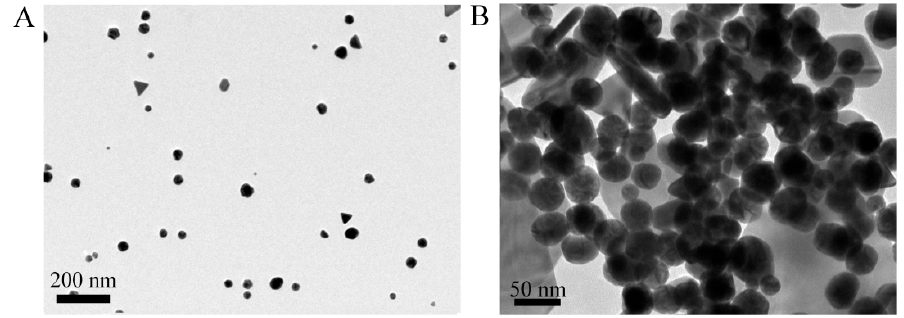
Figure 6. ( A ) TEM of CQDs/AuNPs; ( B ) TEM of CQDs/AuNPs upon I − .